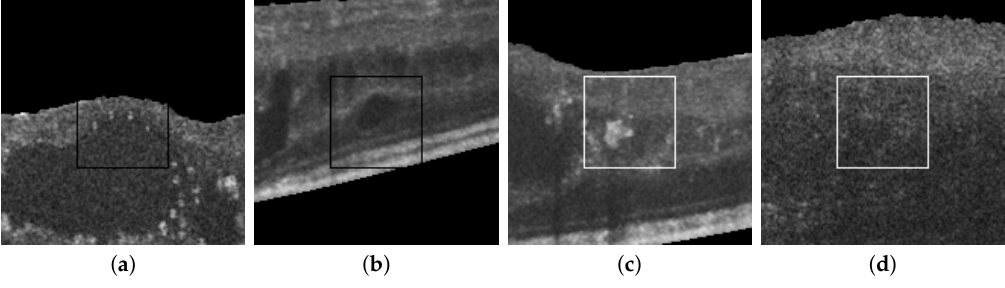
Figure 15. Randomly selected samples from the test dataset labeled by experts that were incorrectly classified by the automatic system. ( a , b ) Cystoid regions classified as non-cystoid. ( c , d ) Non-cystoid regions classified as